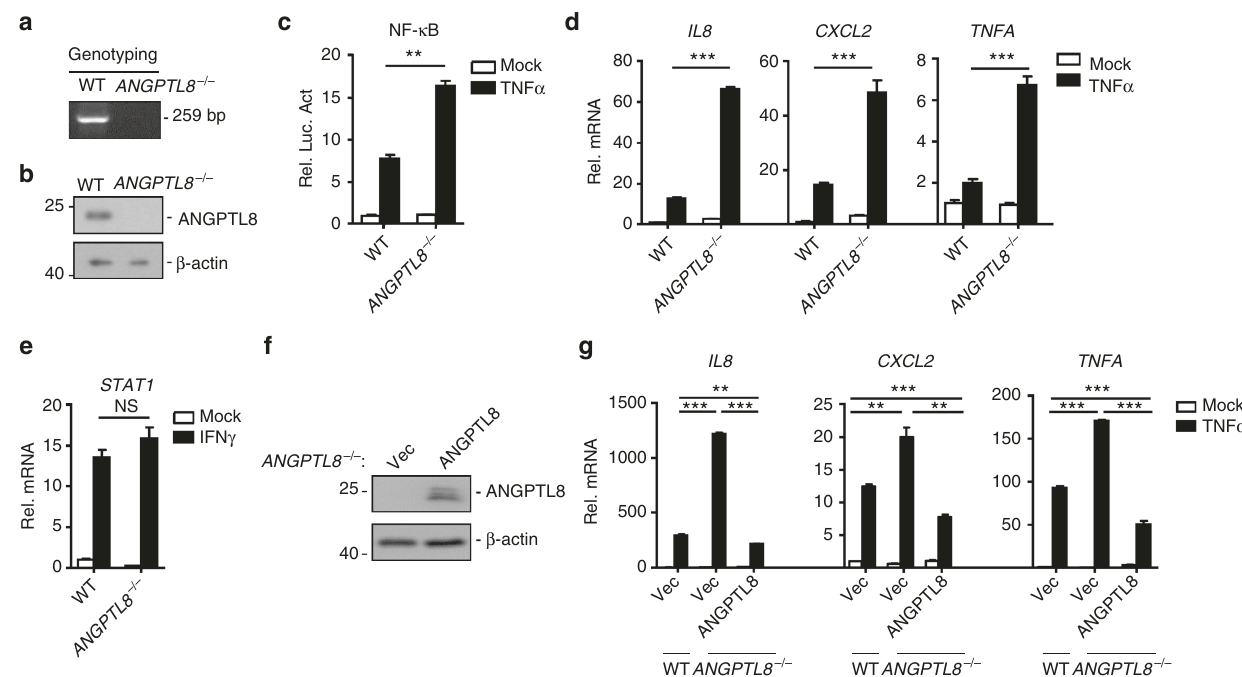
Fig. 3 Knockout of ANGPTL8 potentiates TNF α -induced NF- κ B activation. a Genotyping of ANGPTL8 − / − and wild-type HepG2 cells. b The expression level of ANGPTL8 in ANGPTL8 − / − and wild-type HepG2 cells. c Effects of ANGPTL8 de fi ciency on TNF α -induced NF- κ B activation in luciferase reporter assays ( n = 3). d Effects of ANGPTL8 de fi ciency on TNF α -induced IL8 , CXCL2 and TNFA transcription ( n = 3). e Effects of ANGPTL8 de fi ciency on IFN γ -induced